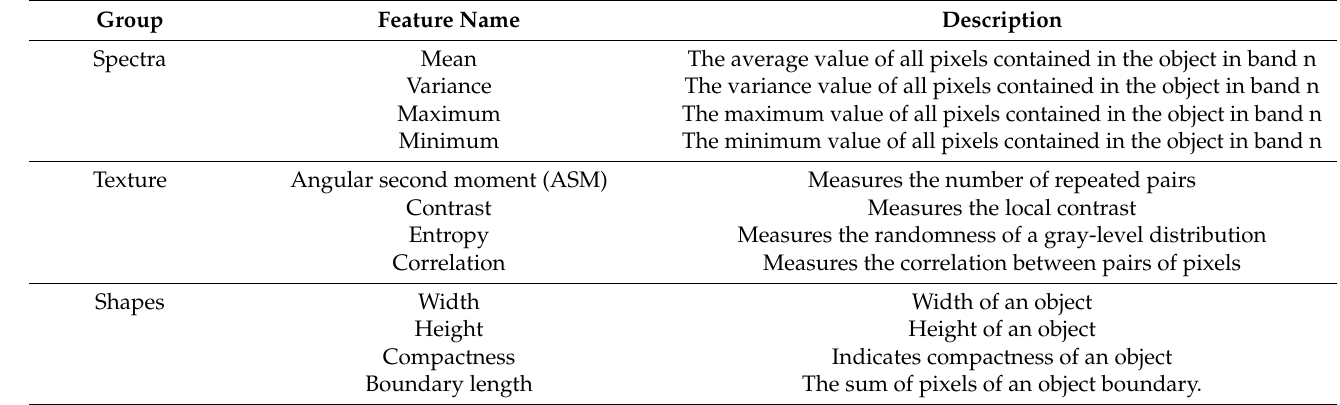
Table 2. Features used in this